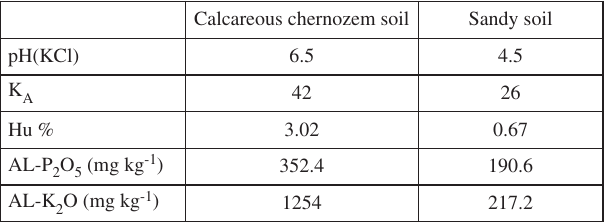
: Plasticity index according to K A